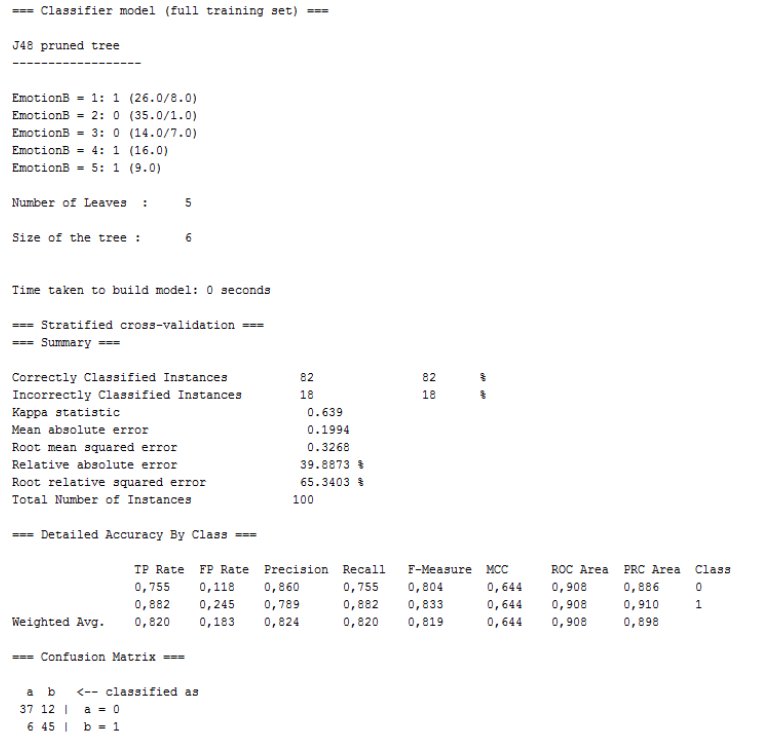
Figure A4. Trees J48 Results for the Specific Model.